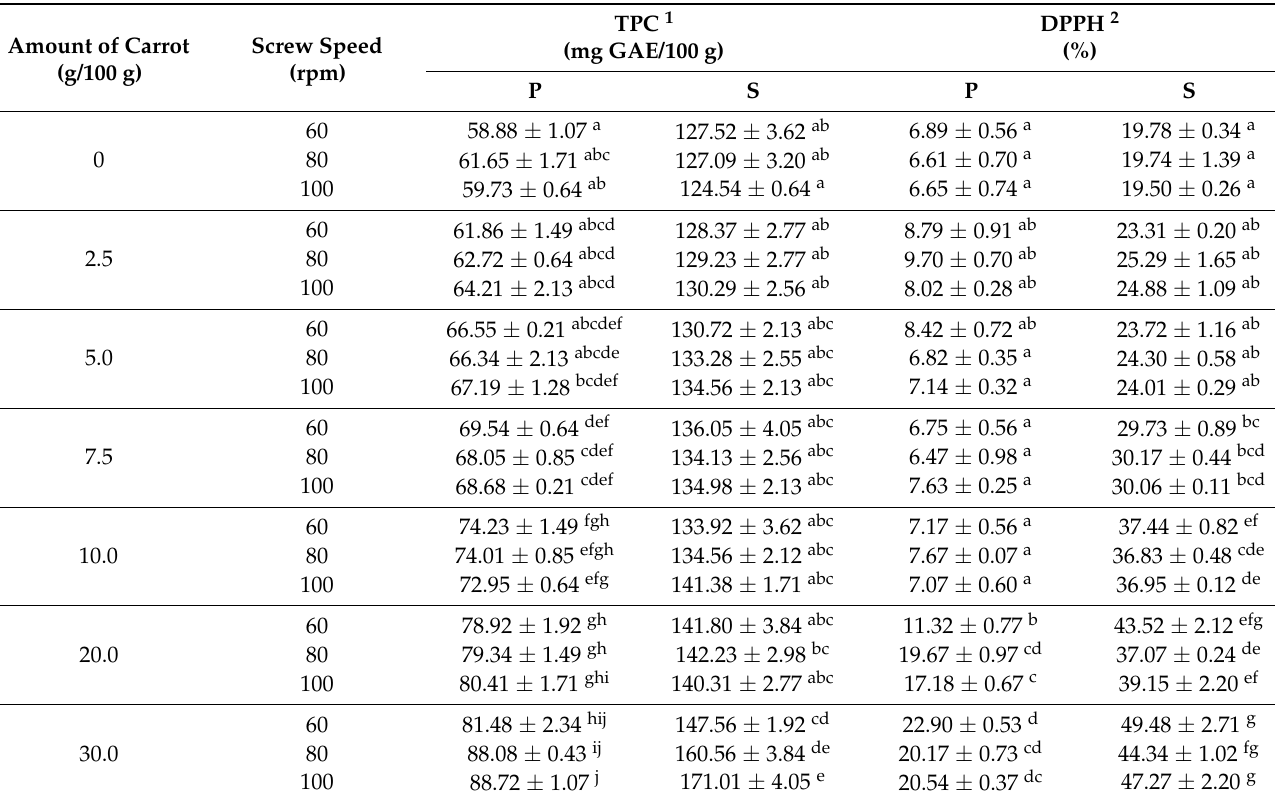
Table 1. Total phenolic content and antioxidant activity of pellets and microwave-expanded snacks supplemented with fresh carrot